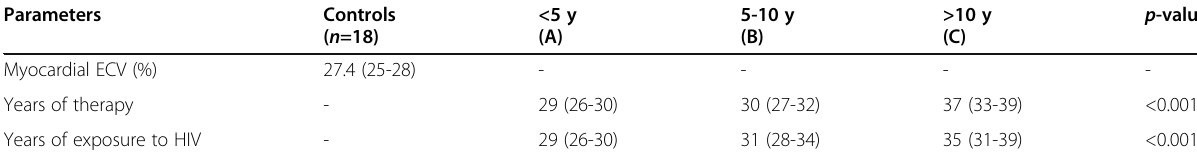
Table 2 Myocardial ECV comparisons between control group and HIV-positive patients selected by (A) less than 5 years, (B) from 5 to 10 years and (C) greater than 10 years. Data are shown as Median and interquartile range (IQR: